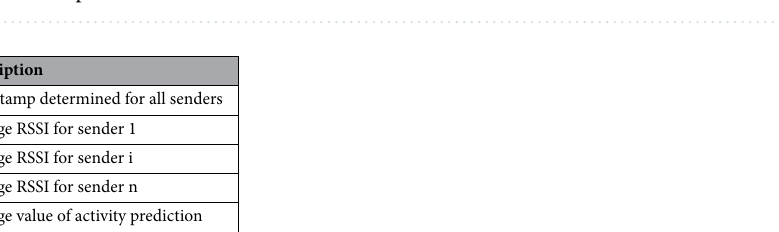
Figure 2. An overview of the experiment.